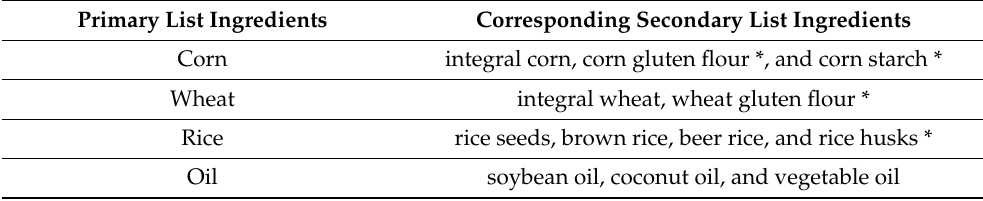
Table 3. Secondary class ingredients retrieved from product composition labels. Primary List Ingredients